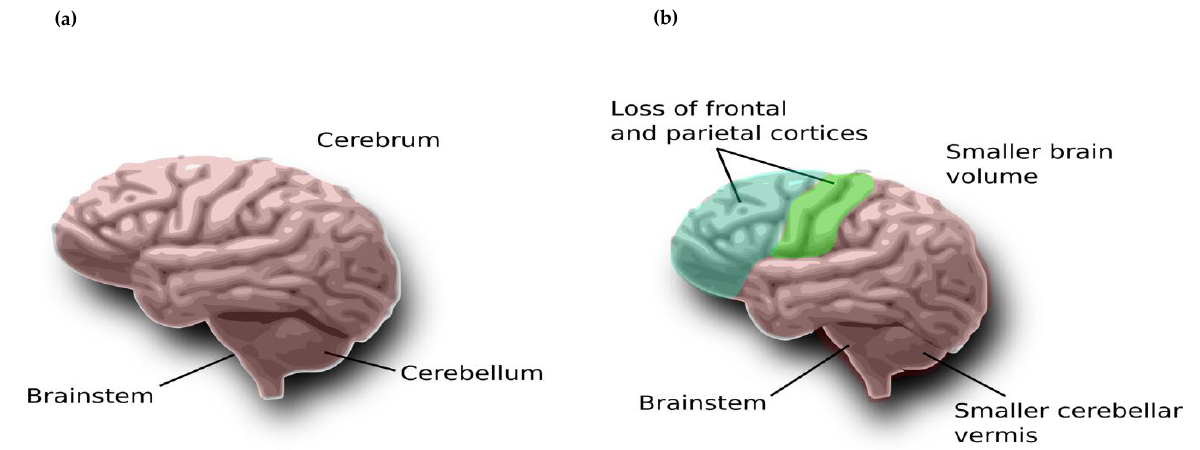
Figure 1. ( a ) Normal brain and ( b ) ADHD brain with smaller volume.